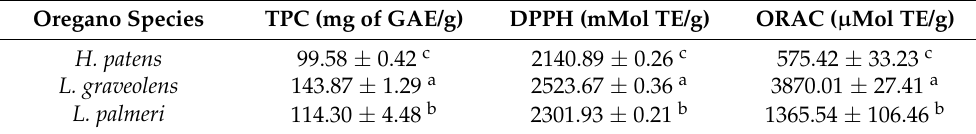
Table 1. Results of total phenolic content (TPC) and antioxidant capacity (DPPH, ORAC) of PRE of three oregano